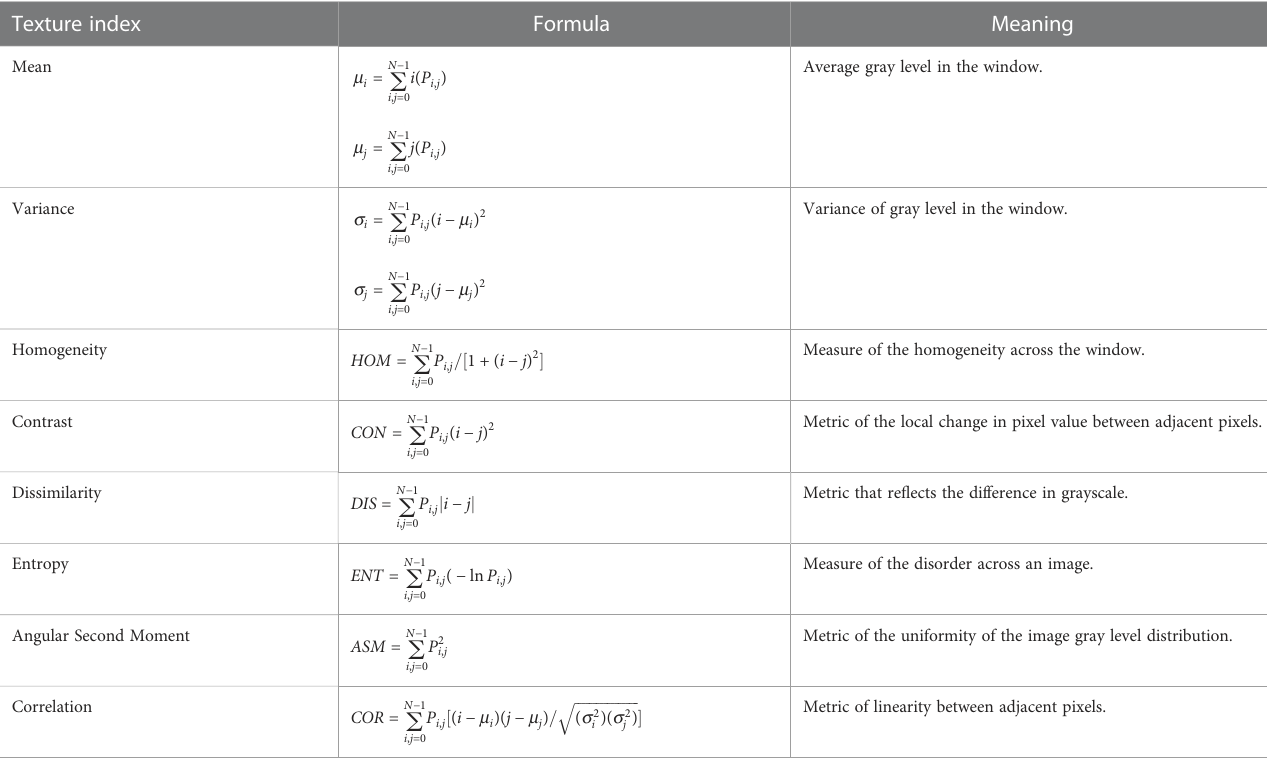
TABLE 3 Meanings and formulas of the selected texture indices based on GLCM. Texture index